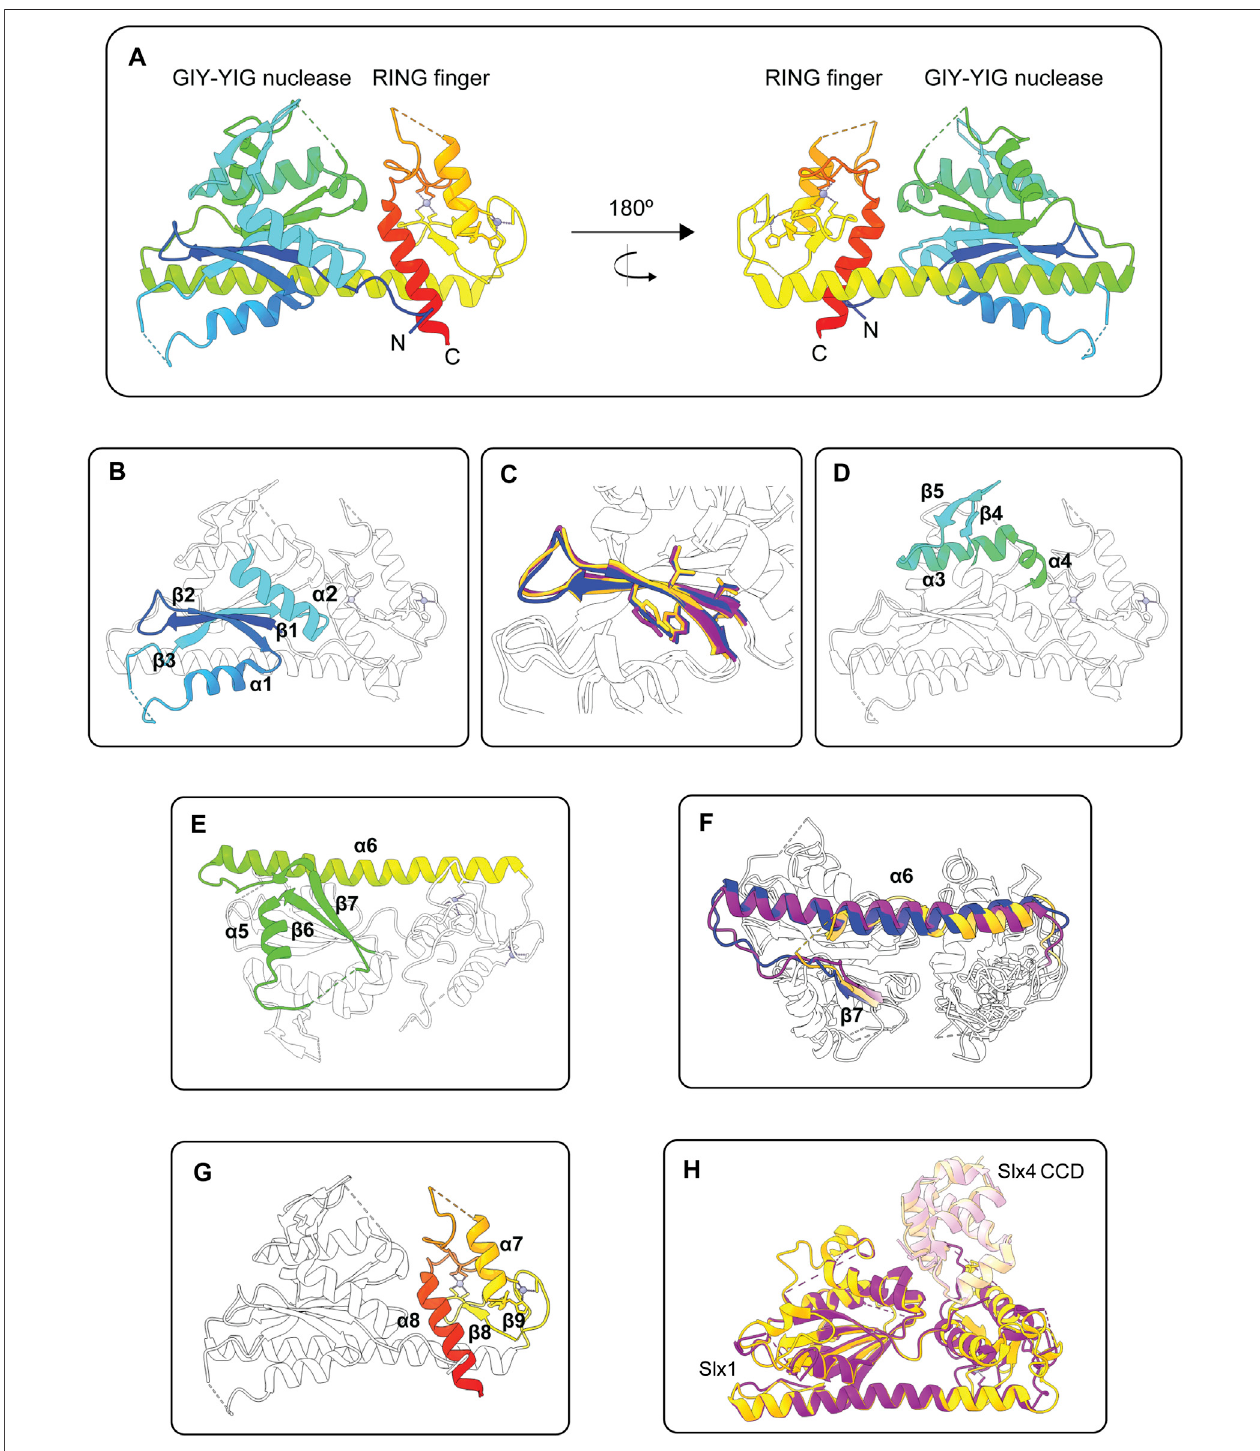
FIGURE 4 | Structures of the Slx1 monomer and Slx1-Slx4 heterodimer. (A) Overall structure of Candida glabrata Slx1 shown in rainbow color (PDB: 4XM5). Zinc ionsareshownasgreyspheresandcoordinationresiduesareshowninstickformat.Dottedlinesindicateloopregionsthatwerenotvisibleintheelectron densitymaps. (B) Structure of C. glabrata Slx1 showing the structural elements of the GIY-YIG nuclease domain in rainbow color ( β 1- β 2- α 1- β 3- α 2) and the rest of the protein in white (PDB: 4XM5). (C) Close-up of the GIY-YIG hairpin from C. glabrata Slx1 (purple; PDB: 4XLG), Thielavia terrestris Slx1 (blue; PDB: 6SEH) and Saccharomyces cerevisiae Slx1 (gold; PDB: 7CQ3). Residues forming the GIY-YIG motifsare shown in stick format. Note the subtle sequence variation in these motifs between species: GCY-YIG in C. glabrata Slx1, CCY-YVG in T. terrestris Slx1 and TVY-YIG in S. cerevisiae Slx1. (D,E) Structure of C. glabrata Slx1 showing features in the nuclease